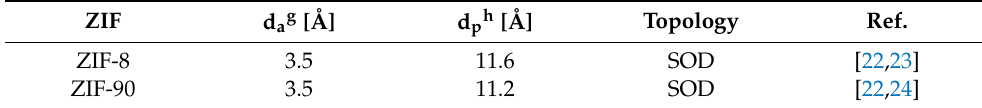
Table 1. Pore entrance size (d ag ), the pore/cage capacity (d ph ) and topology of the ZIFs examined.